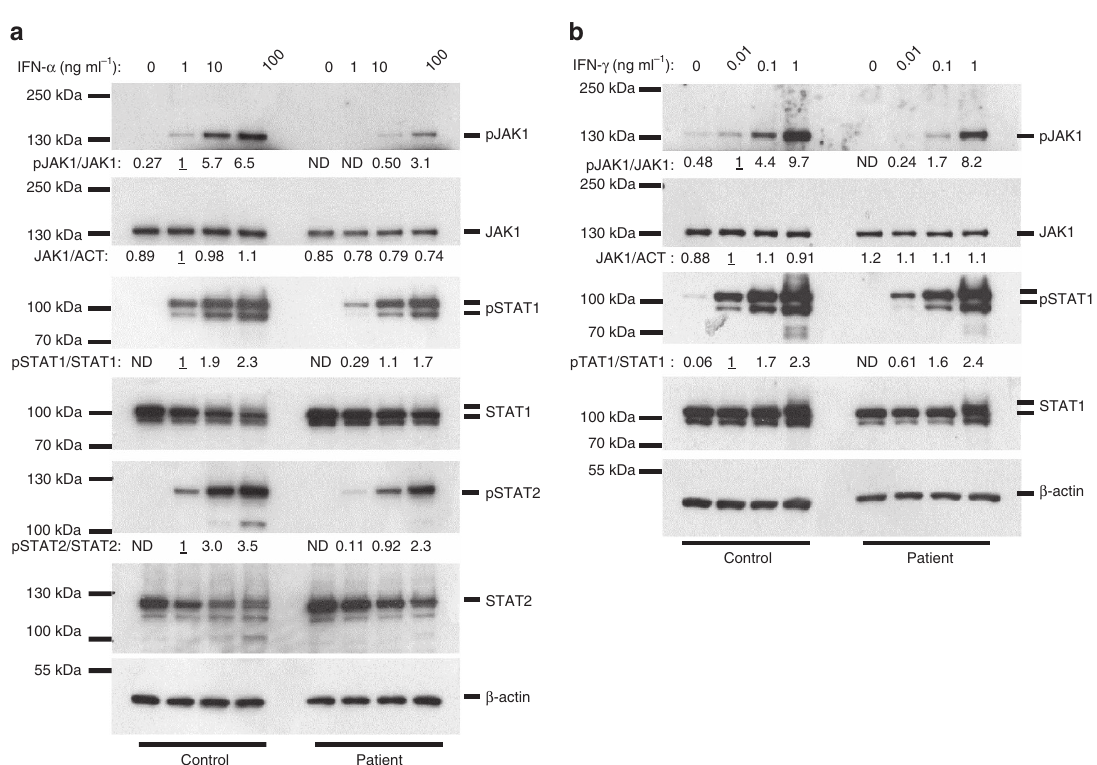
Figure 3 | Impaired JAK1-mediated signalling in the patient’s fibroblasts. ( a , b ) Primary fibroblasts from the patient or a healthy control were treated with the indicated concentrations of IFN- a ( a ) or IFN- g ( b ) for 15min and protein extracts were subjected to immunoblotting. Representative of three independent experiments. Fold change of band densitometry is indicated (numbers below bands and bar graphs in Supplementary Fig. 6).